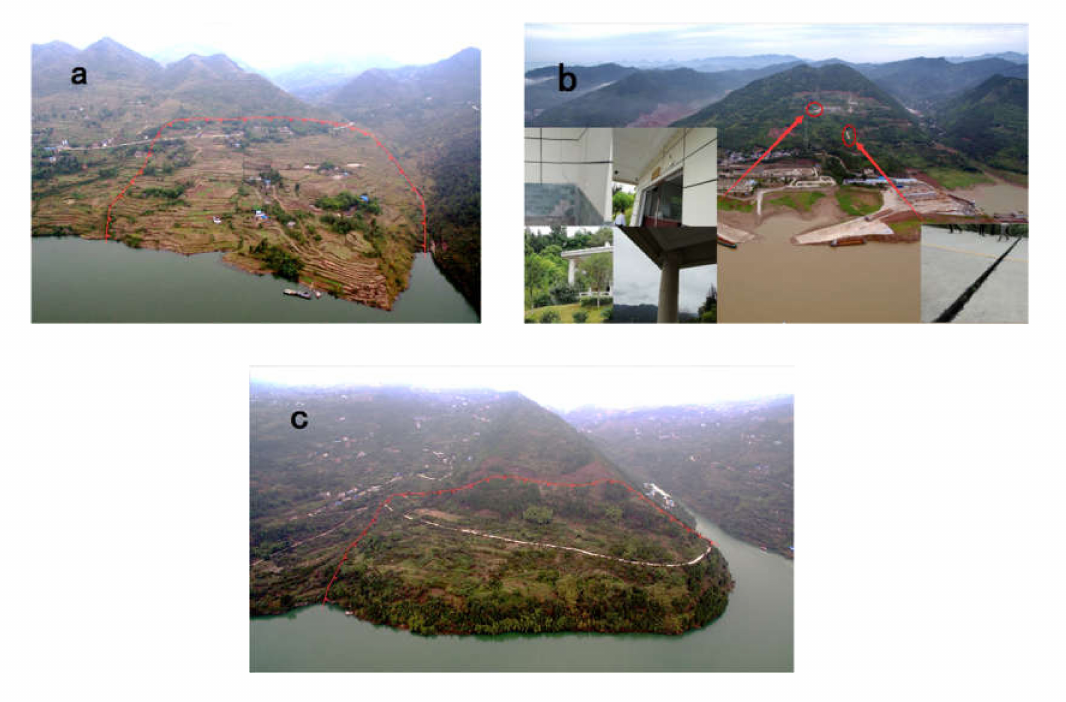
Figure 5. Typical landslides: ( a ) Dashiban Landslide (1 April 2014); ( b ) Jiuxingping Landslide (15 June 2012); and ( c ) Liekou Mountain Landslide (1 April